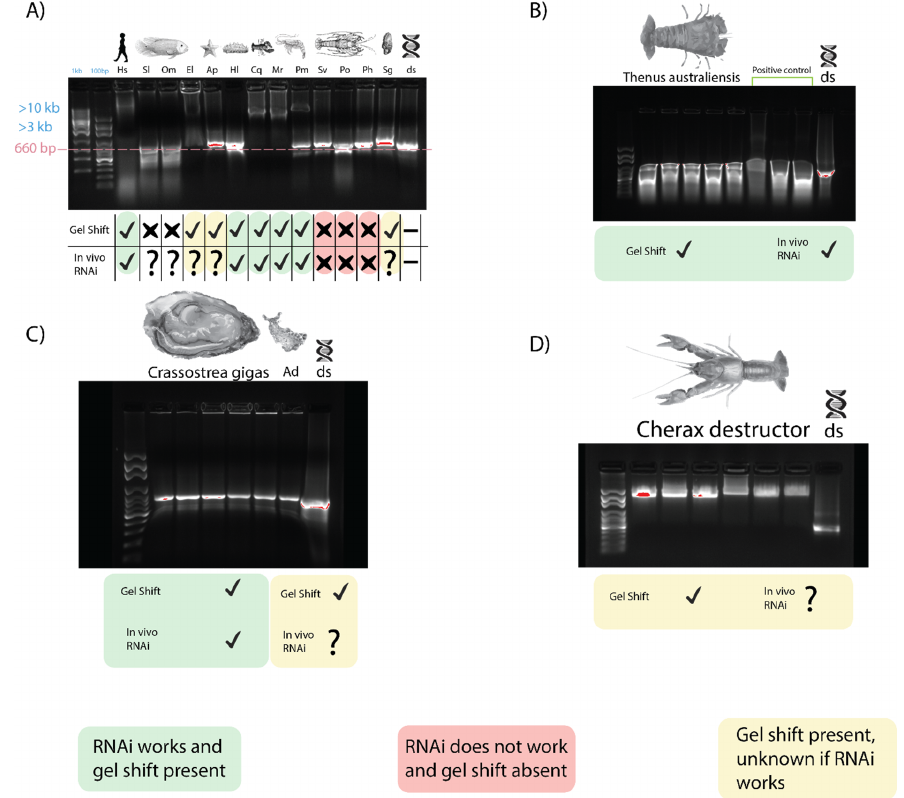
Figure 4. Gel shift trend across phyla. For all lanes, sera (with appropriate anticoagulants when needed) were isolated and incubated with dsRNA for 10 min before being subjected to gel electrophoresis to identify dsRNA binding capacity. A green mark implies a gel shift was observed, and dsRNA-induced exogenous RNAi is functional. Red implies RNAi has not been achievable despite repeated attempts and no gel shift was seen. Yellow implies a gel shift was seen, but data on RNAi capacity is lacking. ( A ) The dsRNA binding activity of sera from invertebrate and vertebrate species. From left to right are Homo sapiens ( Hs) , Seriola lalandii ( Sl) , Oreochromis mosambicus (Om) , Epinephelus lanceolatus (El) , Acanthaster planci (Ap) , Holothura leucospilota (Hl) , Cherax quadricarinatus (Cq) , Macrobrachium rosenbergii (Mr) , Penaeus monodon (Pm) , Sagmariasus verreauxi (Sv) , Panulirus orantus (Po) , Panulirus homarus (Ph) , Saccostrea glomerate (Sg), and a dsRNA control. ( B ) Serum from Thenus australiensis and dsRNA with a positive control from Bombyx mori , where this phenomenon has been documented previously. ( C ) Serum dsRNA binding of Crassostrea gigas and Aplysia dactylomela (Ad). Gel shift is modest, but present in both mollusks. ( D ) Serum from Cherax destructor and dsRNA. Incubation of dsRNA with sera from various mollusk species, including Saccostrea glomerata , Crassostrea gigas , and Aplysia dactylomela (Figure 4A,C) showed a modest inhibition of dsRNA migration with a retarded band with a mobility of ~1 kbp in size, while the lone dsRNA remained at 660 bp. This gel shift appears to be unique to Mollusca . In C. gigas , exogenous RNAi has been observed, which is consistent with our trend, while exogenous RNAi has not been reported in the other mollusks we tested [44].